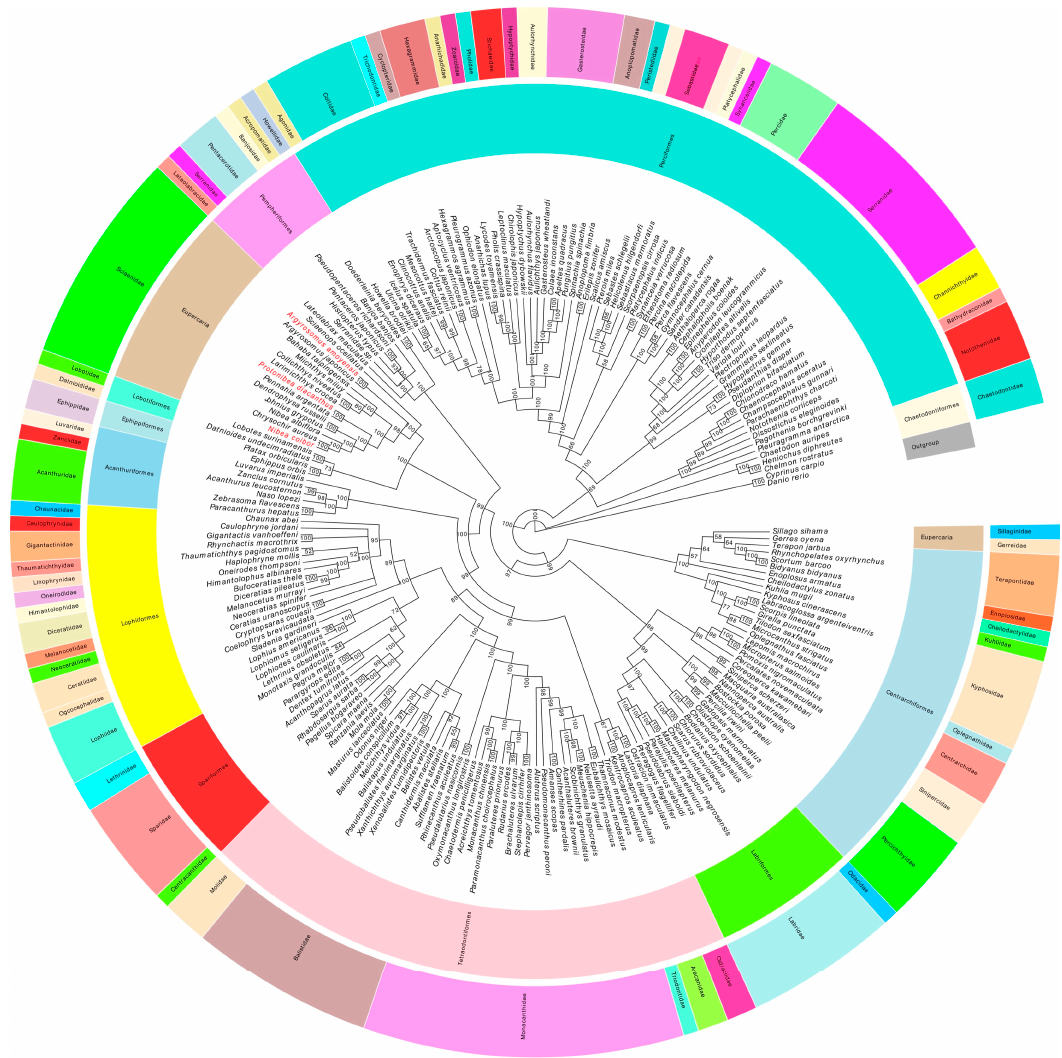
Figure 8. Bayesian inference (BI) tree inferred from the amino acid sequences of 13 PCGs of 204 species of Series Eupercaria including 2 out-groups ( Cyprinus carpio and Danio rerio ). The numbers at the nodes showed the Bayesian posterior probabilities. The species in red Latin name indicated the sequences generated in this study.